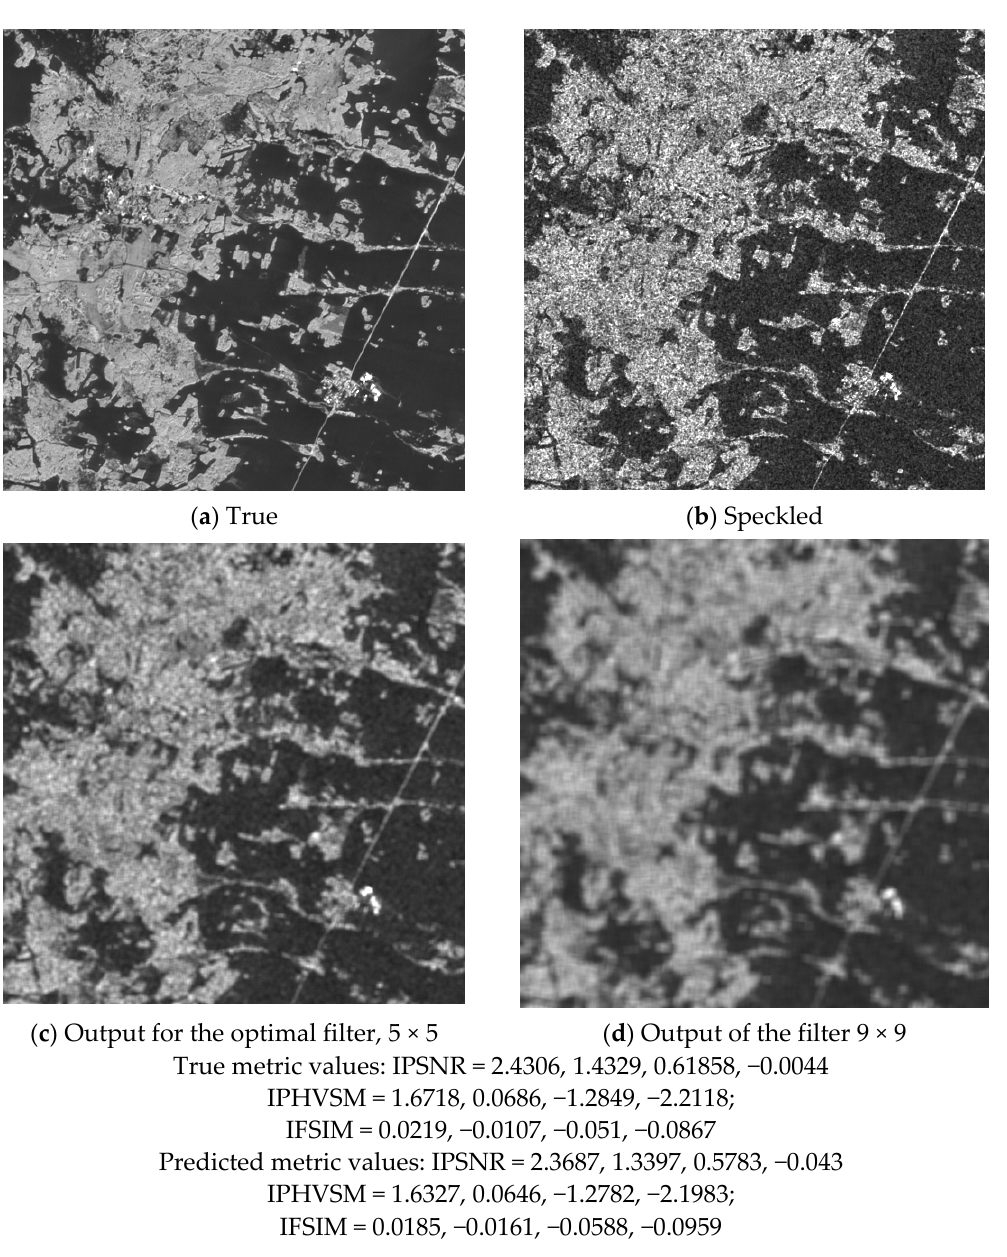
Figure 19. The true image ( a ); the speckled image ( b ); the optimal filter output for the 5 × 5 scanning window ( c ); and the filter output for the 9 × 9 scanning window ( d ).